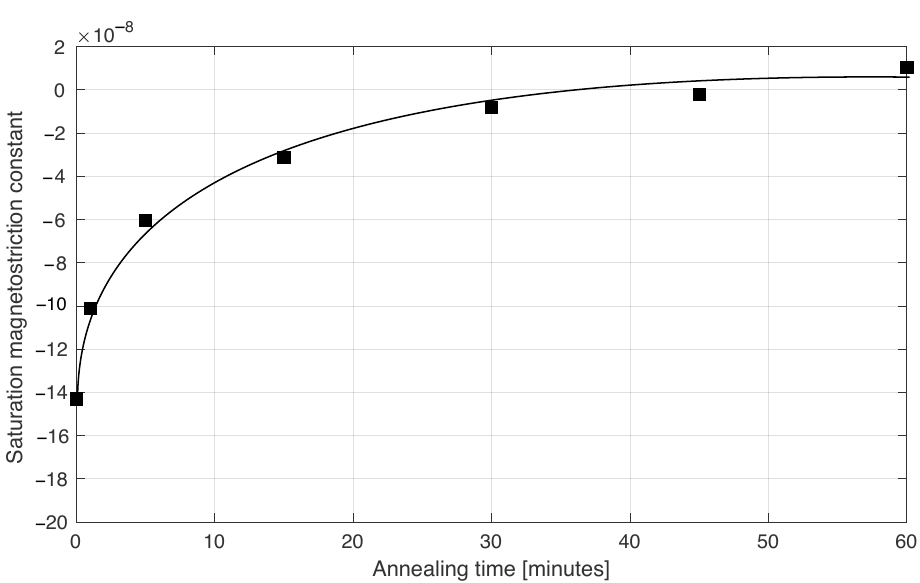
Figure 6. Saturation magnetostriction constant λ S (top) of a wire with a nominal composition of ( Co ) 72.5 Si 12.5 B 15 , produced at the Institute of Material Sciences of Madrid, vs. annealing time. 0.942 Fe 0.058